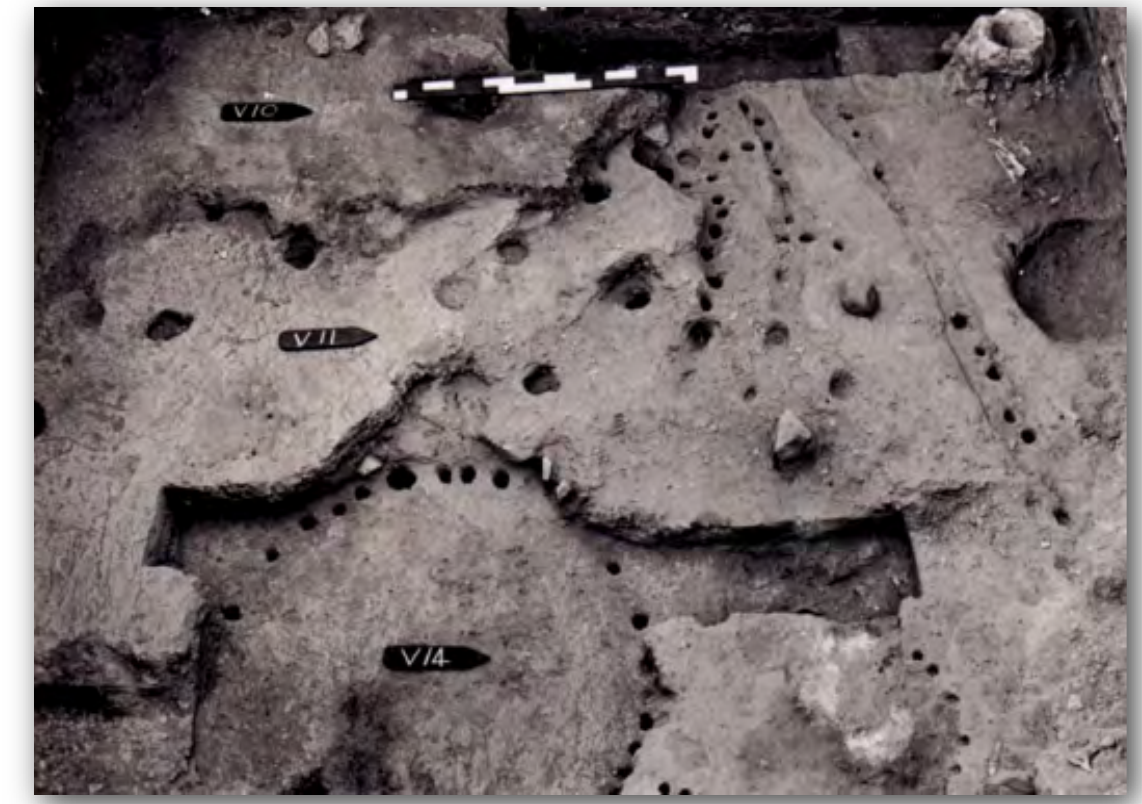
Figure 14. The circular row of wall post holes of a small hut enclosing a well compacted gravel floor, surrounded by a vertical sequence of outside or open-air gravel floors, situated adjacent to several parallel palisade type wall remains that consist of post holes in straight or slightly curved wall trenches (Meyer 1998:156, Figure